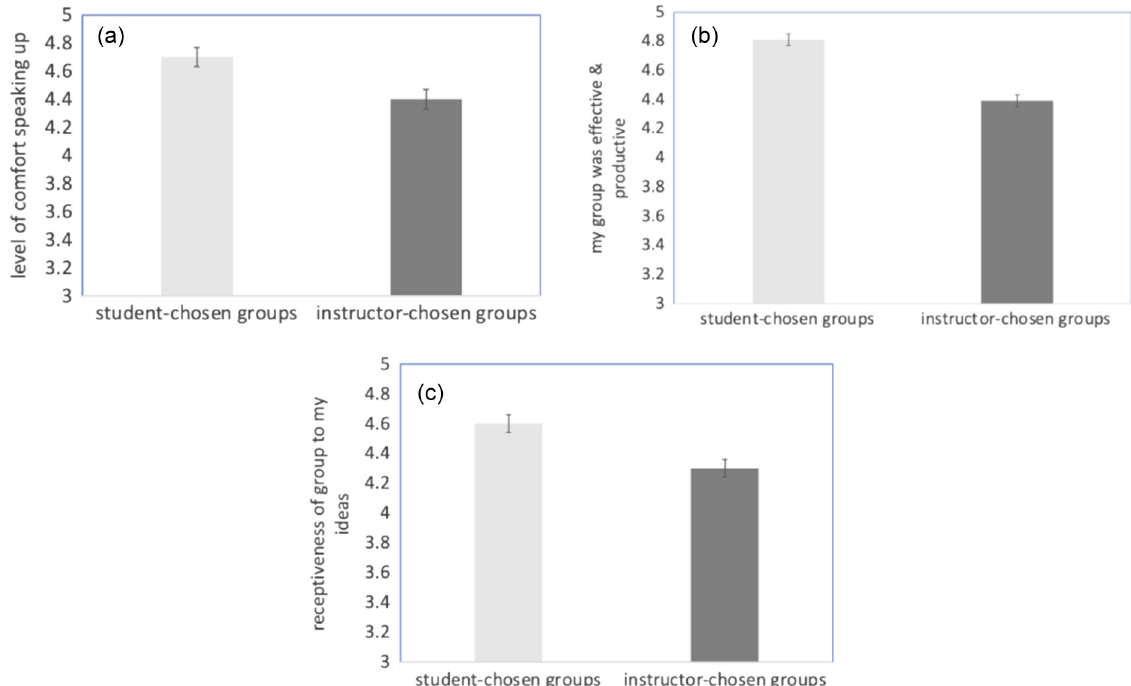
FIG. 6. (a) – (c) Average response of students in student-chosen groups versus instructor-chosen groups for survey questions: (a) During the group exam, I felt comfortable speaking up; (b) during the group exam, my group was effective and productive; and (c) during the group exam, my group members were always receptive to my ideas and